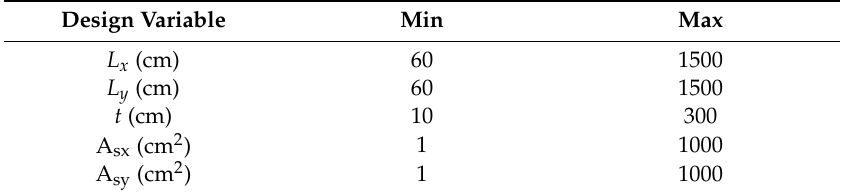
Table 4. Design variables with their corresponding domains and